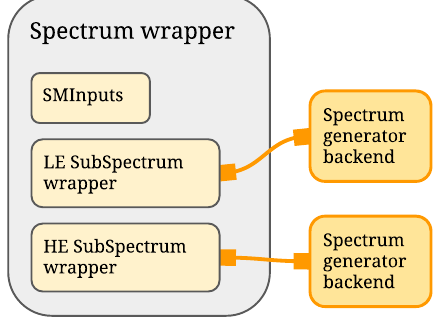
Fig. 3 Schematic representation of a Spectrum object. Basic Stan- dard Model “input” information is contained in a structure call SMInputs (upper-left light-yellow box), the content of which mirrors the correspondingly named SLHA2 block. Low scale (generally < m Z ) spectrum information is wrapped by a “low-energy” SubSpectrum object(centre-leftlight-yellowbox).Highscale(generally > m Z )spec- trum information is wrapped in a “high-energy” SubSpectrum object (lower-left light-yellow box). This split mirrors a common require- ment of spectrum generators that Standard Model input parameters be first supplied at a common scale, then run by the “low-energy” SubSpectrum object to a matching scale, after which the main spec- trum generation for the BSM model is performed and wrapped into the “high-energy” SubSpectrum object. The outer Spectrum object provides a uniform interface to these underlying structures and makes it easy to retrieve common parameters such as pole masses without the need to interact directly with the